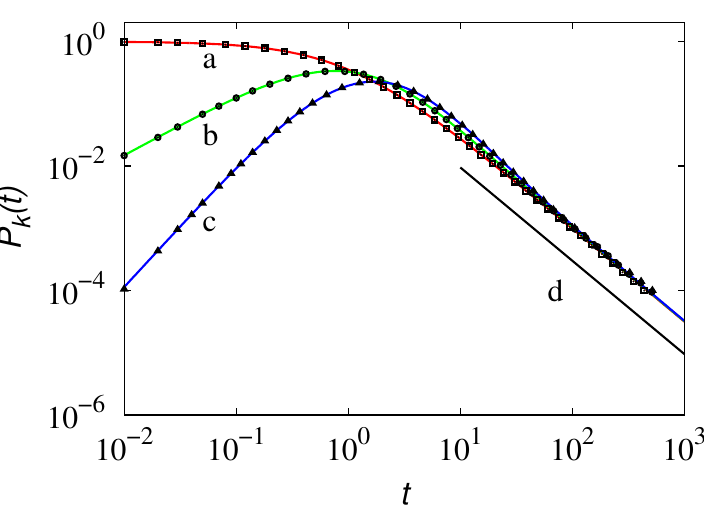
Figure 1. P k ( t ) vs. t for the simple counting process defined by Equation (15) with τ 0 = 1, ξ = 1.5. Lines (a) to (c) refer to k = 0,1,2, respectively. Line (d) corresponds to the asymptotic scaling P k ( t ) ∼ t − ξ